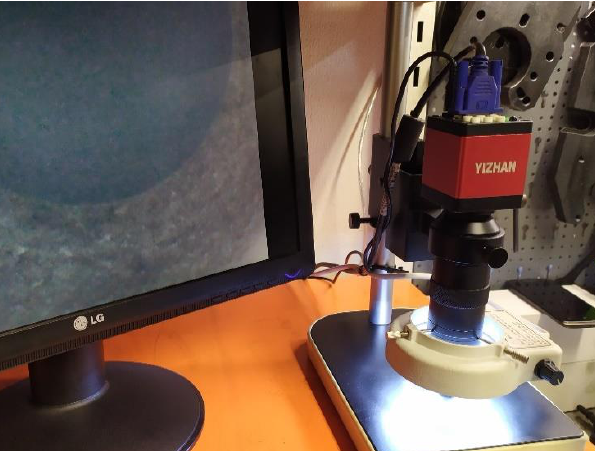
Fig. 8. Examination of the valve seat on a microscope stand